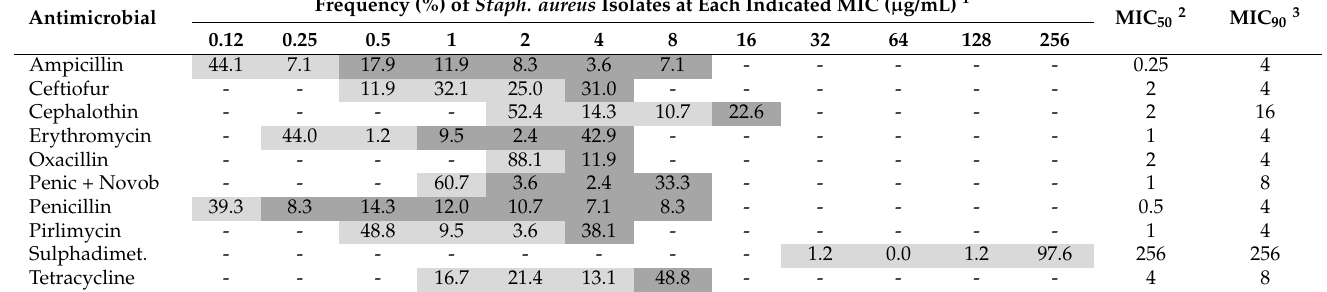
1 The light gray shading represents the susceptible zone, and the darker gray shading represents the resistant zone. Results were interpreted according to CLSI [24,25]. Interpretative criteria were based on human data (ampicillin, cephalothin, erythromycin, oxacillin, penicillin, sulfadimethoxine and tetracycline), and bovine mastitis (ceftiofur, penicillin + novobiocin and pirlimycin). The resistant category included isolates categorized as either intermediate or resistant; 2 MIC ( µ g/mL) that inhibited 50% (MIC 50 ) of the isolates; 3 MIC ( µ g/mL) that inhibited 90% (MIC 90 ) of the